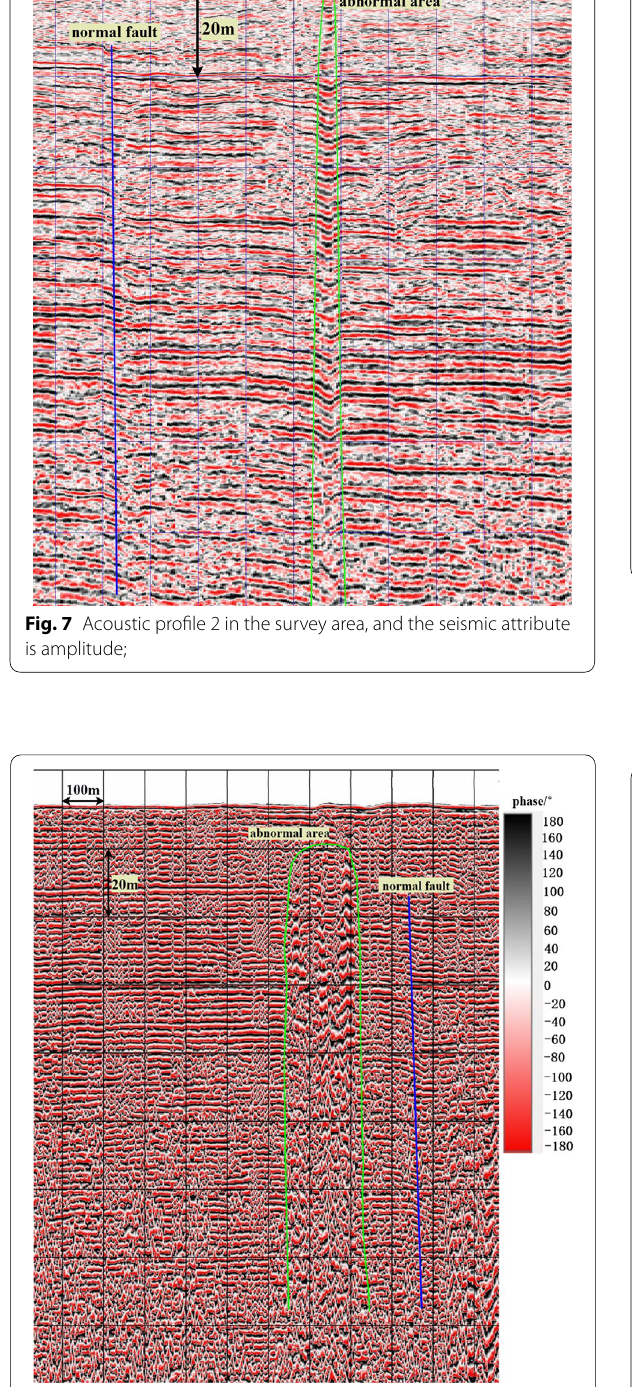
Fig. 8 Acoustic profile 1 in the survey area, and the seismic attribute is the phase for Fig. 6